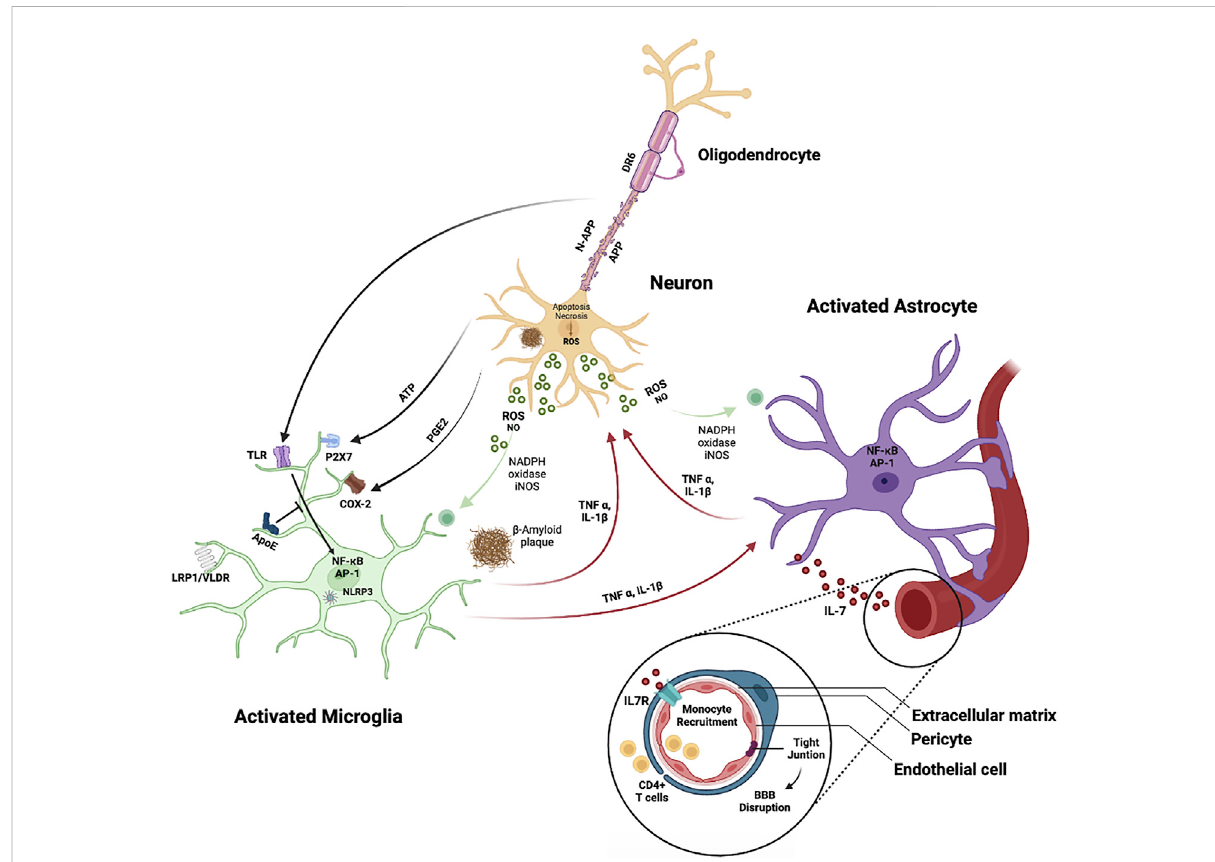
FIGURE 2 Cellular interactions in Alzheimer ’ s disease (AD). Cleavage of the amyloid precursor protein (APP) results in the formation of amyloid- β peptide (A β ) that aggregates and accumulates forming the amyloid plaques. These aggregates activate microglia cells via Toll-like receptors (TLRs) and receptor for advanced glycation end products (RAGE), altering the transcriptional program of the microglia cells and stimulating the expression of transcriptionfactorssuchasAP-1andNF- κ B,whichinturntriggertheproductionofreactiveoxygenspecies(ROS)andin fl ammatorycytokines. These cytokines enhance the proin fl ammatory environment by stimulating astrocytes, which act directly on the neuronal population, causing neuronal cell death. Neuronal apoptosis results in release of ATP, which then activates microglia via the purinergic P2X7 receptor, initiating an autostimulatory loop that induces T-cell in fi ltration. In AD, endothelial cells and pericytes are dysregulated, causing BBB disruption, and the number of oligodendrocytes is reduced, resulting in diminished neuron